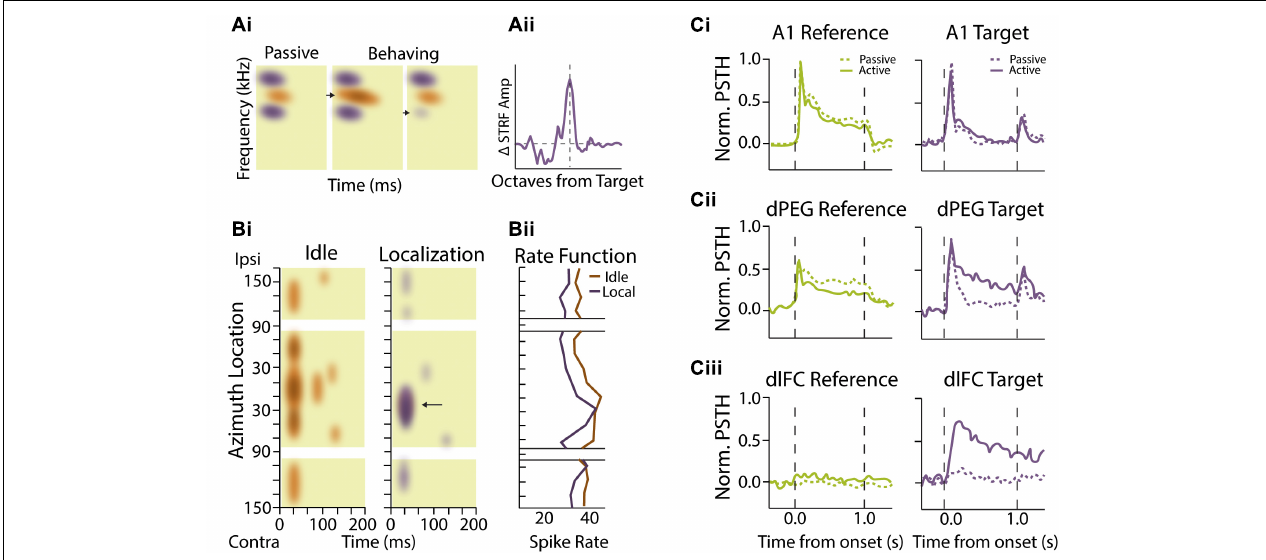
FIGURE 2 | Attentional and task-dependent modulation of sound feature encoding. (Ai,ii) Spectrotemporal receptive fields (STRFs) in auditory cortical neurons change based on task engagement and target frequency. (Ai) Example STRF showing enhanced sensitivity (orange) and sideband inhibition (purple) during passive presentation of broadband temporally orthogonal ripple combinations (TORC) stimuli (left). Performance of a tone detection task with peak STRFs near the target frequency (arrow) enhances the excitatory region in the STRF during behavior (middle). When tonal targets were presented with frequencies that coincided with inhibitory STRF, (arrow) the STRF showed local decreases or elimination of inhibitory sidebands (right). (Aii) Summarized data showing that STRF plasticity adaptation effects are most substantial when near the target frequency with facilitation occurring over ∼ 1 octave from the target stimulus. Schematized data adapted from Fritz et al. (2003). (Bi,ii) Spatial sensitivity modulated by task performance. (Bi) Heat maps demonstrating primary auditory cortex (A1) neural activity as a function of time (horizontal axis) and stimulus location (vertical axis) from a single behavioral session. This neuron shows burst activity at sound onset and is strongly responsive to probe trials originating from all locations during idle conditions (non-task performing condition). During the sound localization task where the cat is rewarded for discriminating changes in elevation, neural responses become more selective for probe trial origin, responding best to stimuli located between contralateral 10 ◦ and 50 ◦ . Arrow indicates increased specificity for this unit at the spatial localization. Colors indicate changes in mean intensity firing rates for the two conditions. (Bii) Rate functions in response to sound onset are shown to the right for the passive and sound location task conditions as a function of stimulus location. Schematized data adapted from Lee and Middlebrooks (2011). (Ci,ii,iii) Effects of task performance on auditory responsivity in auditory and frontal cortices. (Ci) Average behavior-dependent change in reference (green) and target (purple) responses in A1. Reference targets included TORC or narrowband white noise stimuli while targets consisted of pure tones. Dashed lines represent pre-task passive responses while solid lines represent task-engaged response. The average reference and target response as measured by normalized peri-stimulus time histograms (PSTH) amplitude were not significantly different between passive and behavior conditions. (Cii) Target and reference comparison for dorsal posterior ectosylvian gyrus (dPEG) of the ferret which is a belt region receiving A1 input. dPEG shows an average target response augmentation during task performing conditions. (Ciii) Target and reference PSTH comparison for dorsal lateral frontal cortex (dlFC), an executive region important for cue-directed behavior. dlFC neurons show almost no responsivity during passive conditions for either target or reference stimuli; however, they are strongly regulated by the target exclusively during behavior. Schematized data adapted from Atiani et al.